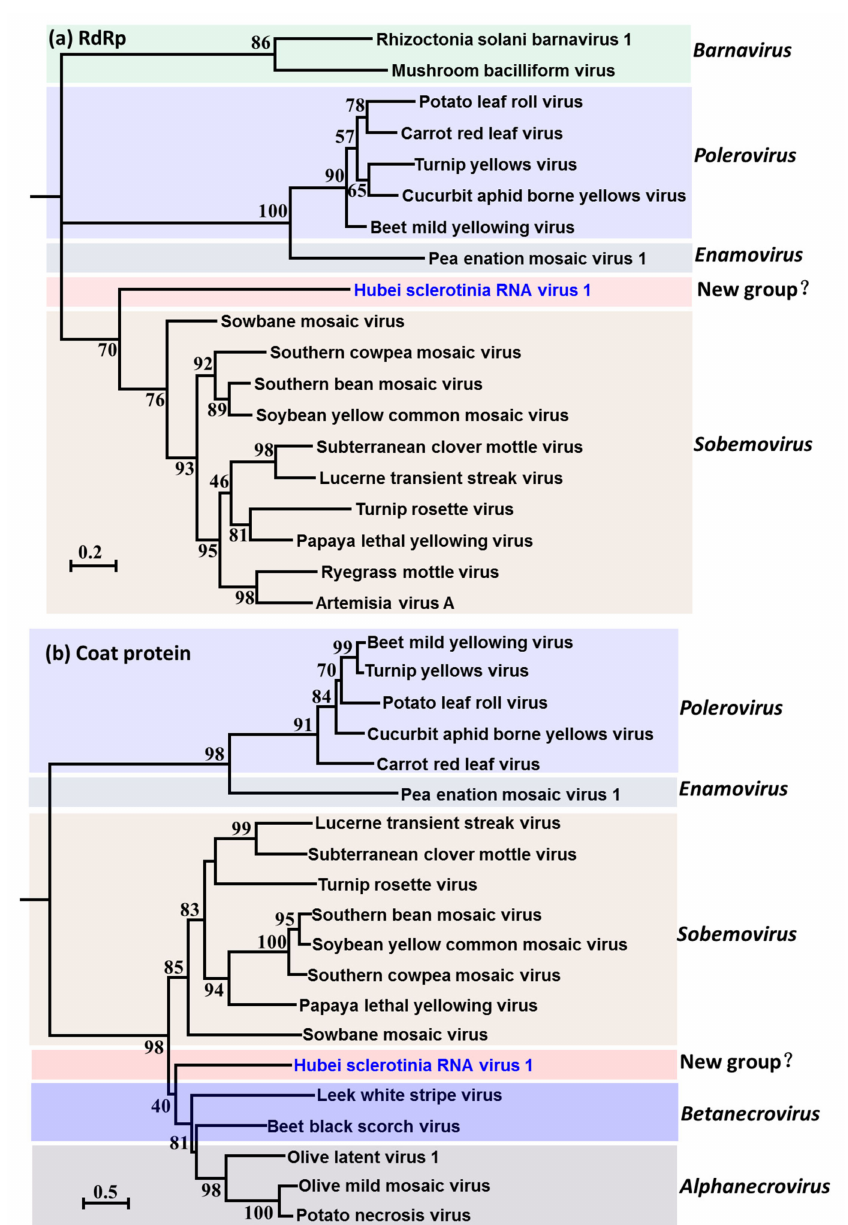
Figure 5. Evolutionary relationship of Hubei sclerotinia RNA virus 1 (HuSRV1). ( a ) An ML phylogenetic tree constructed based on the alignment of the aa sequences of the conserved motifs in the RdRp domain in HuSRV1 and selected viruses from the genera Sobemovirus , Polerovirus , Enamovirus , and Barnavirus . ( b ) Phylogenetic analysis of HbSRV1 and selected RNA viruses from the genera Sobemovirus , Polerovirus , Enamovirus , Betanecrovirus and Alphanecrovirus based on an ML tree inferred from the full sequence of the coat protein. The number on branches indicates results of analyses of 1000 bootstrap replicates, and is shown at the nodes for values greater than 50%. The bar at the lower left quarter represents the genetic distance corresponding to branch lengths. HuSRV1 reported in the present phylogenetic tree was emphasized with blue color. The accession number of viruses used for phylogenetic analysis was listed in Tables S3 and